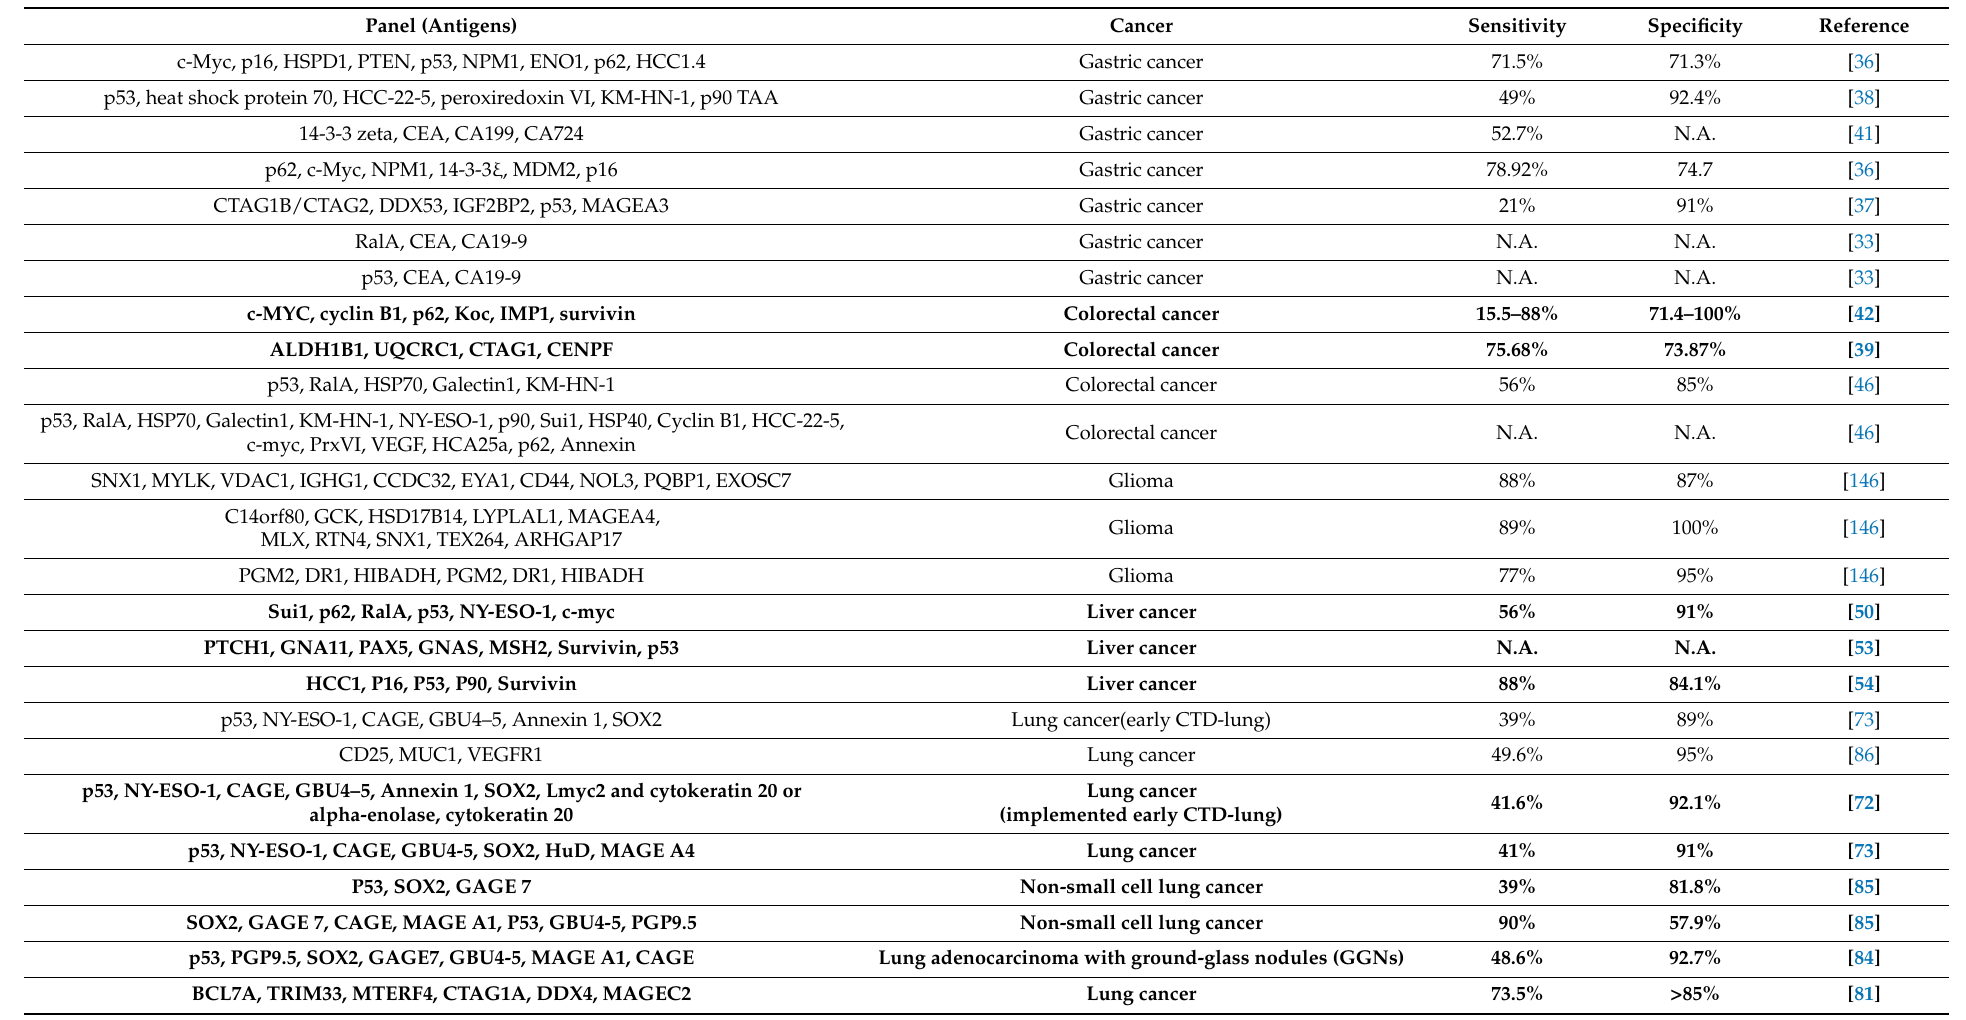
Table 2. Autoantibody panels useful in cancer diagnosis and